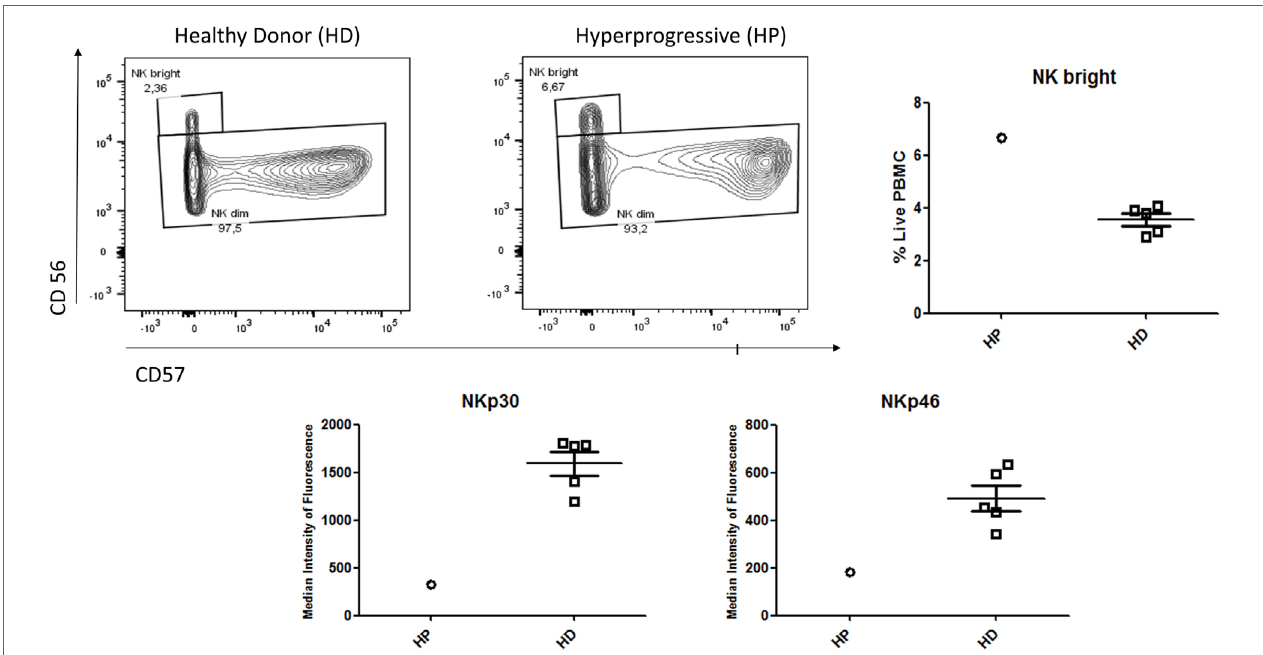
FIgURe 4 | Flow cytometry analysis of NK cells comparing the HP with five HD. Increased proportion of NK bright (CD56 + high) cells in HP compared to HD. Conversely, decreased expression of the receptors NKp30 and NKp46 in HP compared to HD. Abbreviations: HP, hyperprogressive patient; HD, healthy donors; NKp30/NKp46, natural cytotoxicity